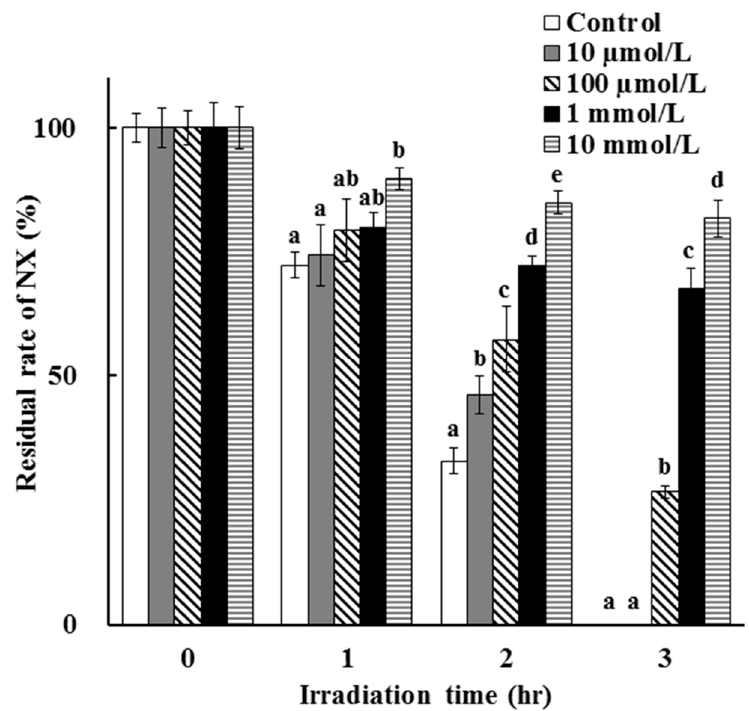
Figure 5. Dose dependency of the photoprotective effect of AA on NX photodegradation in a solution. The values represent the mean ± S.D. ( n = 3). a–e Means without a common superscript are significantly different ( p < 0.05).